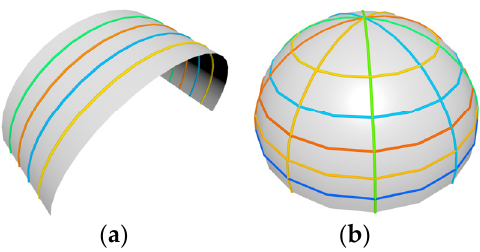
Figure 5. Two ways of slicing of geometries: ( a ) unidirectional slicing; ( b ) bidirectional slicing. Unidirectional stiffeners: Here, we discuss how to optimally stiffen a curved shell with unidirectional